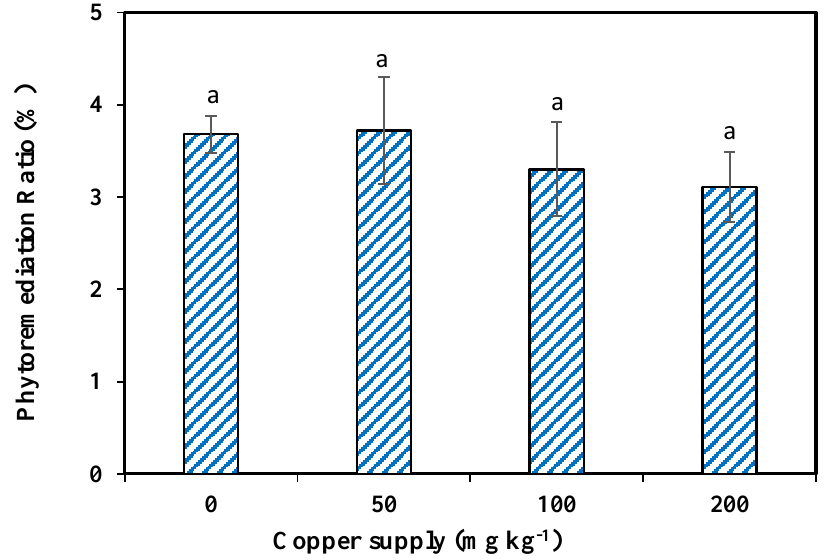
Figure 7. Phytoremediation Ratio (PR) for Cu in the studied treatments. Mean values that do not share a letter are significantly different at p = 0.05 (mean ± S.E.; n = 3).